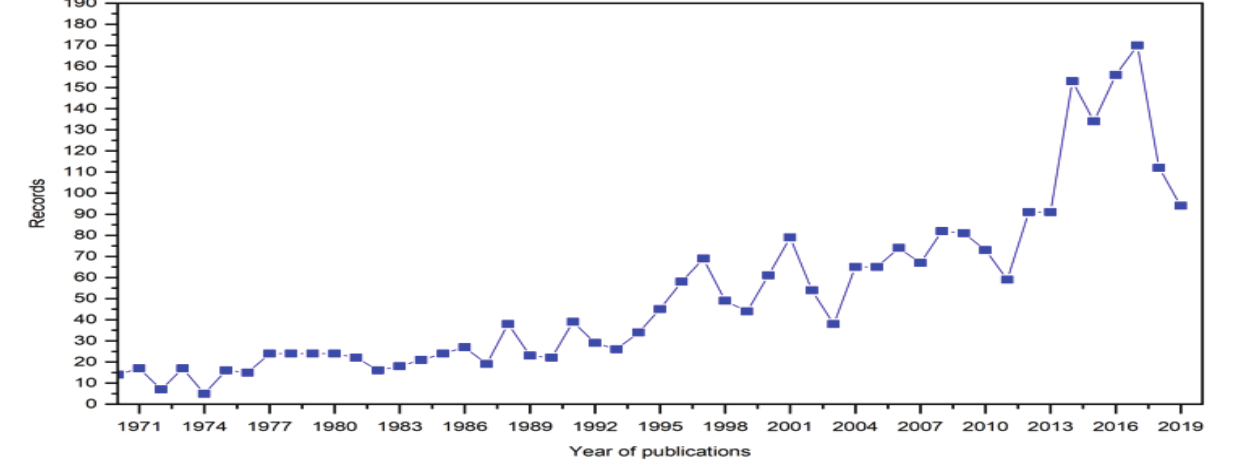
Figure-I: Trend of publications in polio research in the last 50 years.